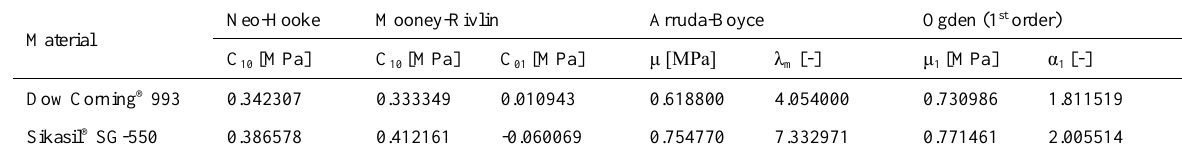
Table 3: Parameters determined for different hyperelastic material models for the two investigated silicone adhesives. Material